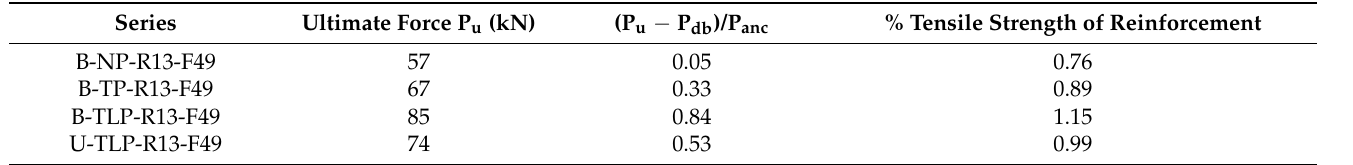
Table 4. Exploitation of sheets and connectors according to results in Sun et al.